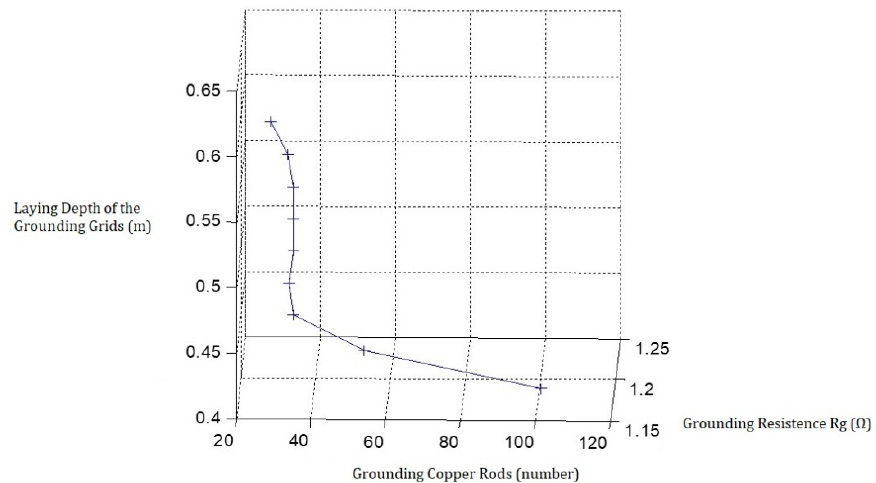
Figure 8. Prediction line of the IEEE Std. 80-2000 adaptation function by MOPSO for h = 0.4 – 0.6 m.